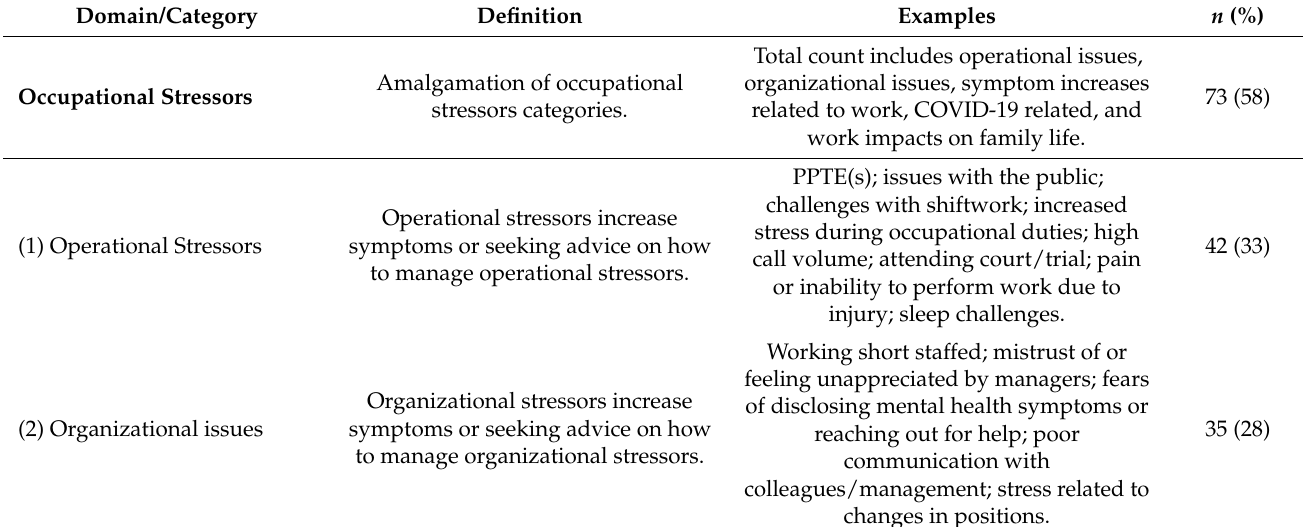
Table 4. Occupational and personal issues shared with